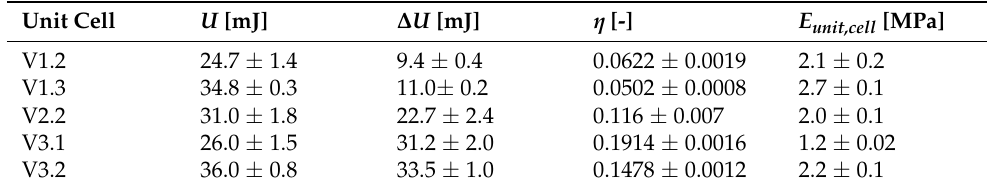
Table 3. Damping and stiffness properties of the tested unit cells.